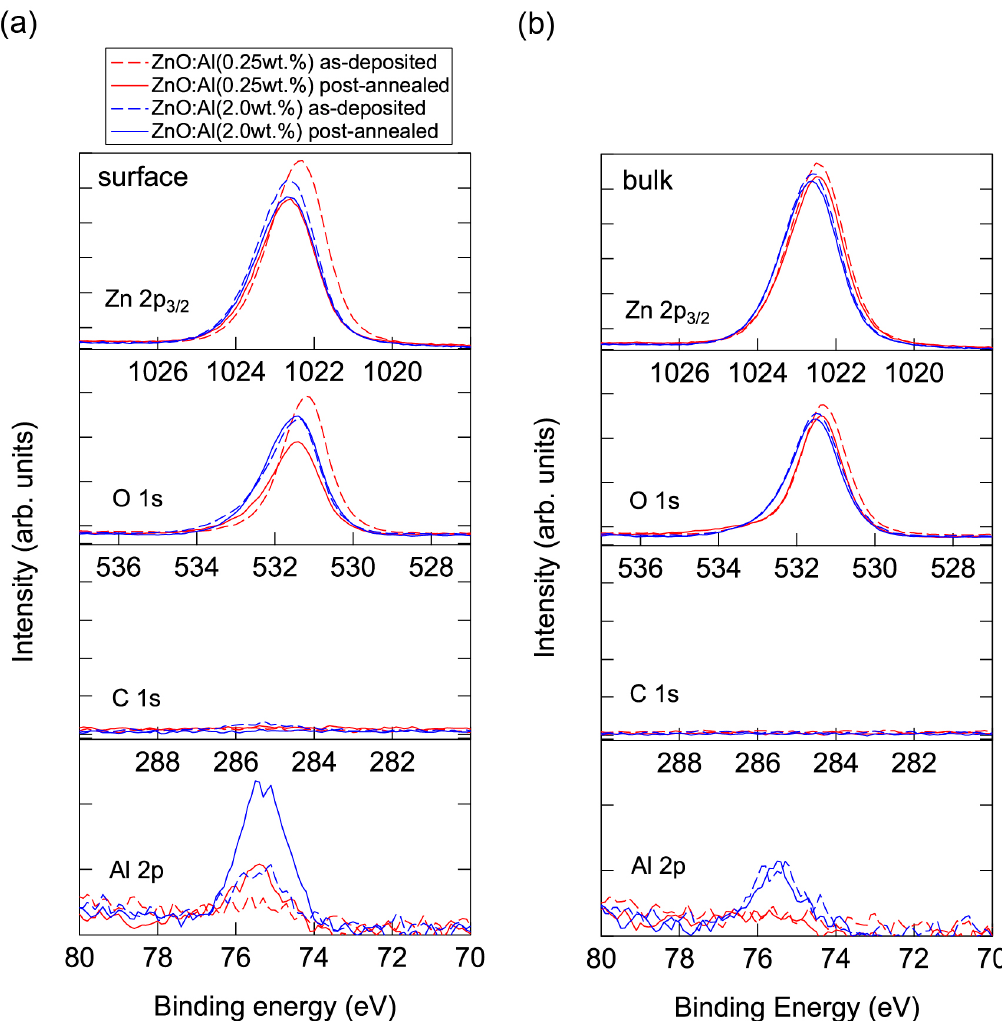
Figure 13. XPS spectra for ( a ) the surface regions and ( b ) the bulk regions of the as-deposited and post-annealed ZnO:Al (0.25 and 2.0 wt %) films at a P O2 of 1 × 10 − 23 atm. Table 1. The concentrations of Al, Zn, and O ( C Al (at %), C Zn (at %), and C O (at %)) estimated from the XPS spectra for the surface and bulk regions of the as-deposited and post-annealed ZnO:Al (0.25 and 2.0 wt %) films at a P O2 of 1 × 10 − 23 atm.